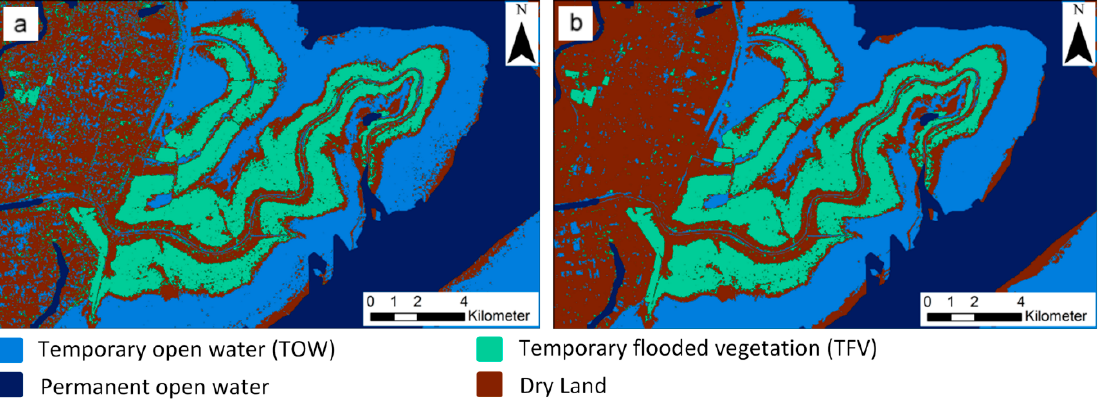
Figure 12. Pixel-based classification result ( a ), object-based classification result ( b ) and validation mask (c) for the study area in China.